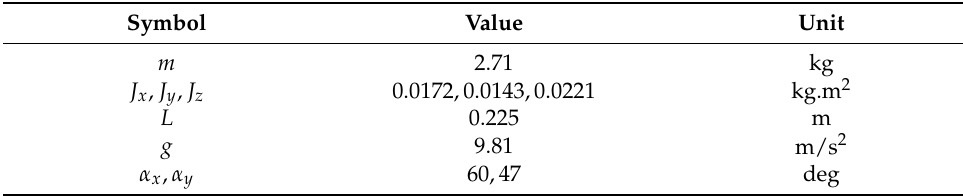
Table 2. The parameters of the quadcopter dynamics and pixy camera’s FOV.